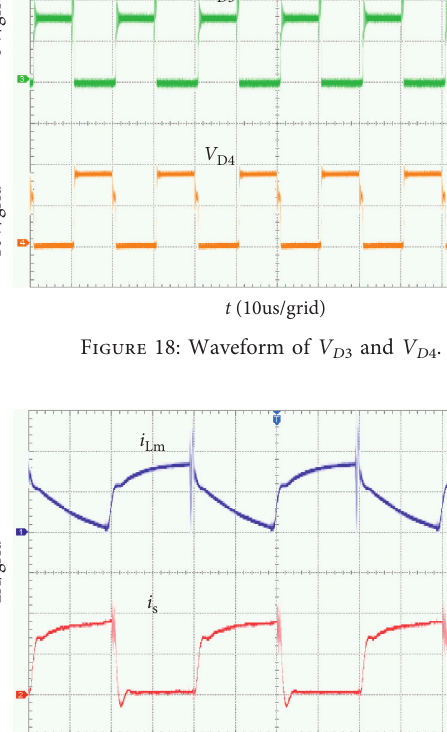
Figure 19: Coupled inductor/switch waveform.